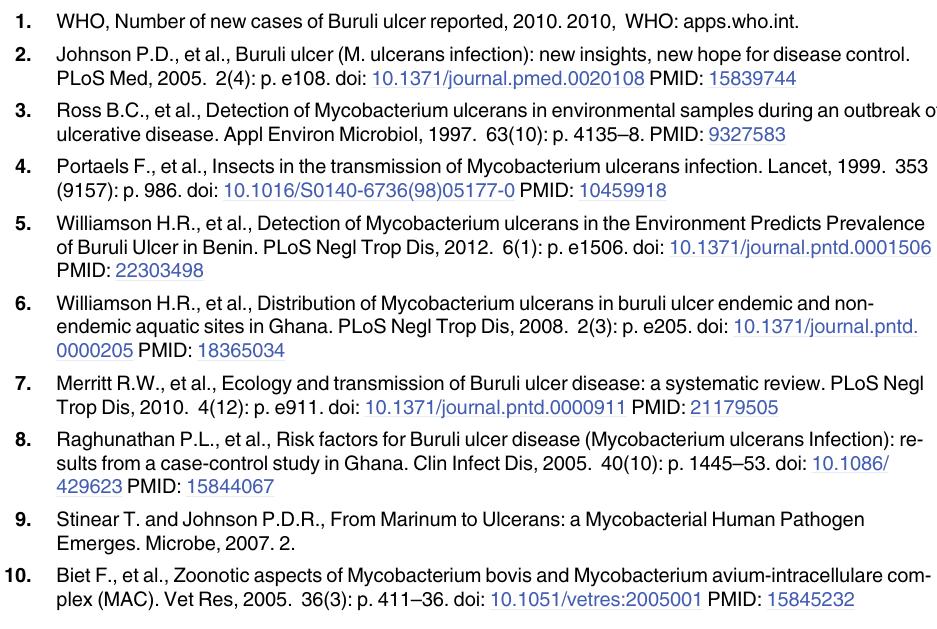
S1 Table. Activities around water bodies. S2 Table. List of primers used for PCR amplifications. S3 Table. Livelihood strategies. S4 Table. VNTR profiles and MPM strain designated genotypes of current study and from published data. W, X, Y and X are M. ulcerans designated genotypes from current study. A, B, C, and D are M. ulcerans designated genotypes from literature. Other published MPM ge- notypes; E is M. marinum DL, MPS is M. pseudoshottsii , MM is M. marinum and F is M. liflan- dii . a & c means identical, b means same genotype as in current study. ND, not done. Gh seq, Ghana